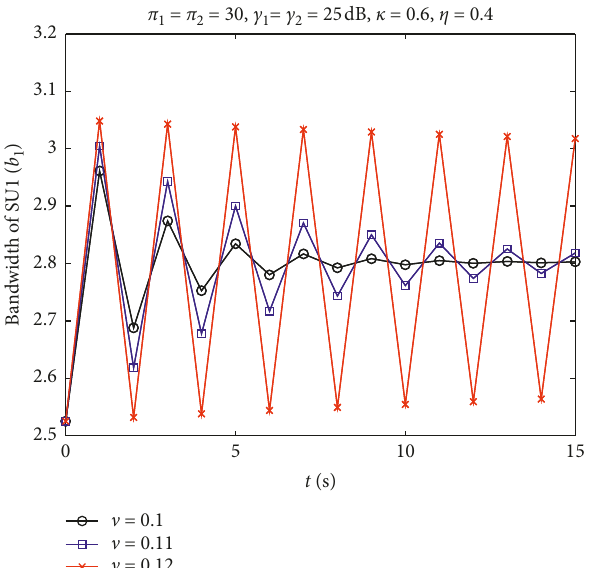
Figure 6: The dynamic behavior of the non-cooperation game for the V-SU 1.